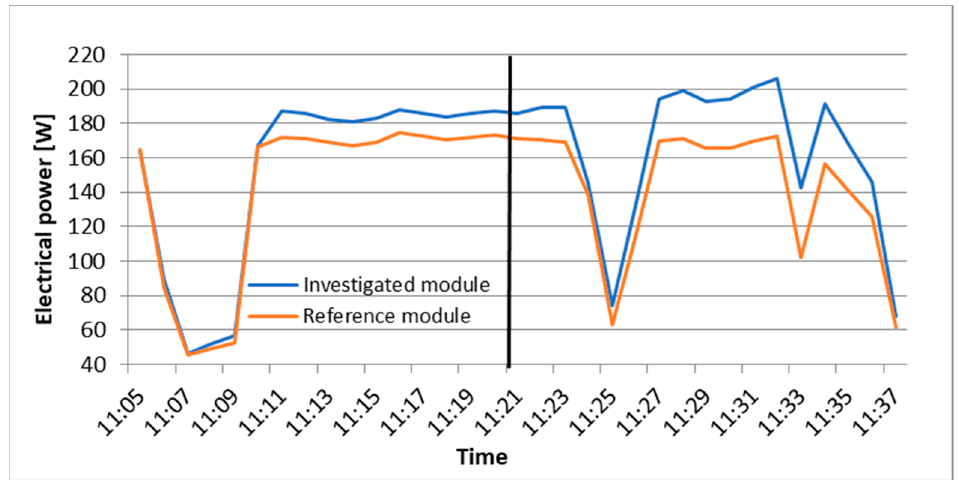
Figure 6. Power of PV modules during the comparative 30-min test.